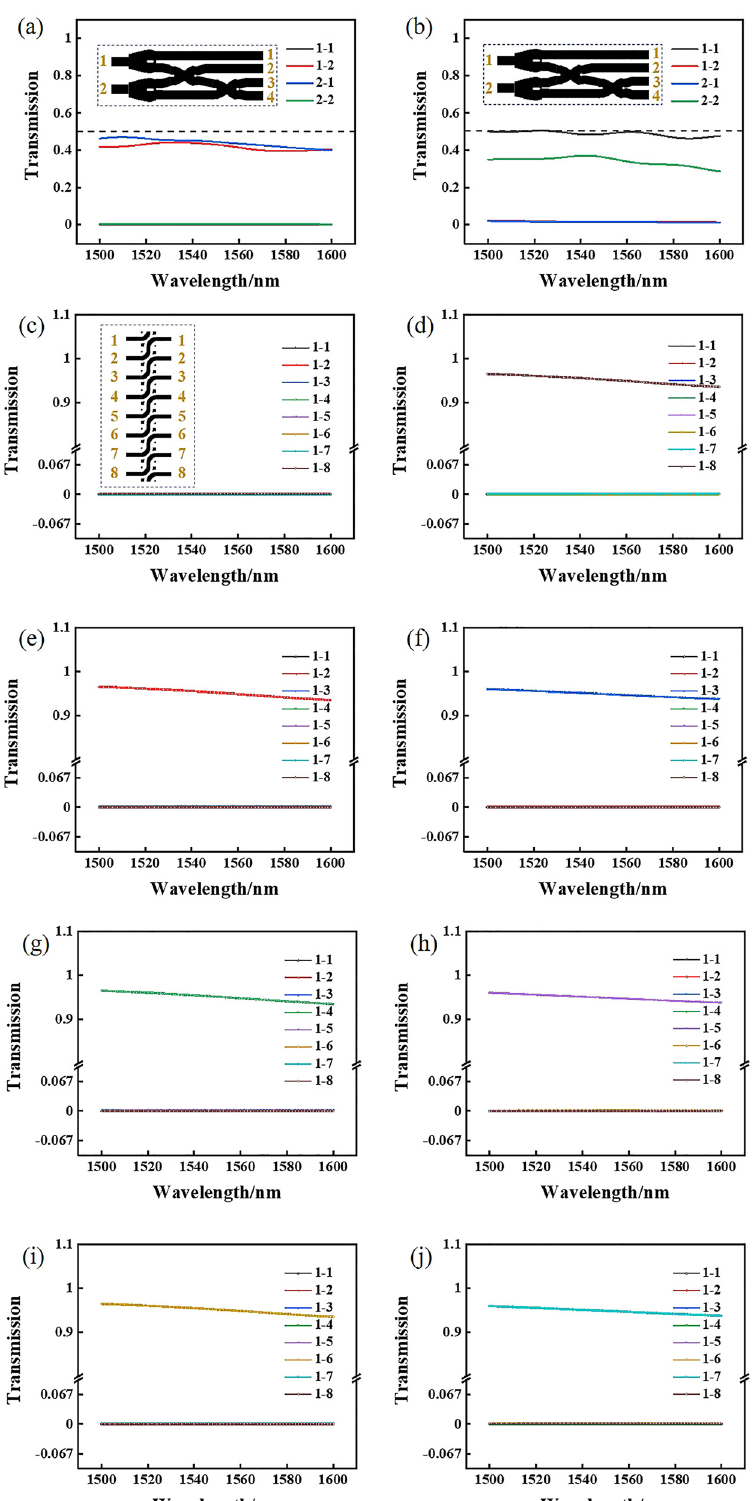
Figure 6: Simulation results of the normalized transmission of all-optical calculation